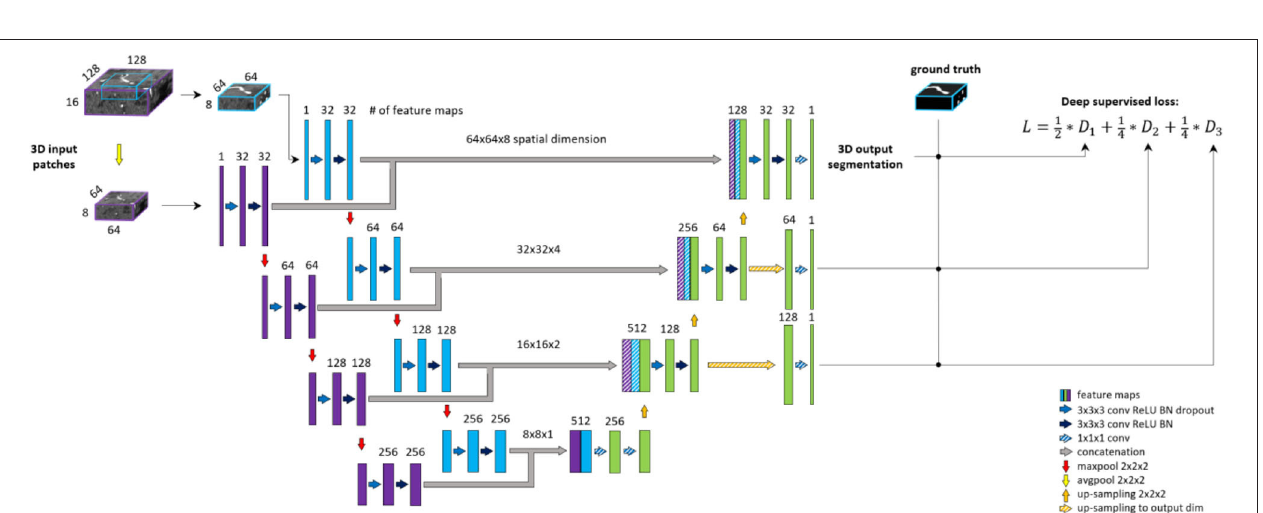
FIGURE 3 | Unet architecture extended with context aggregation, coined Context-Unet . Additional context path (purple columns) is added to the encoding (left side) part. The initial downsampling of the 128 × 128 × 16 input patch is followed by the same number of layers as the other encoding path (blue columns). The two paths are concatenated and fed into the decoding part (right side). Input patches are extracted around the same center voxel.